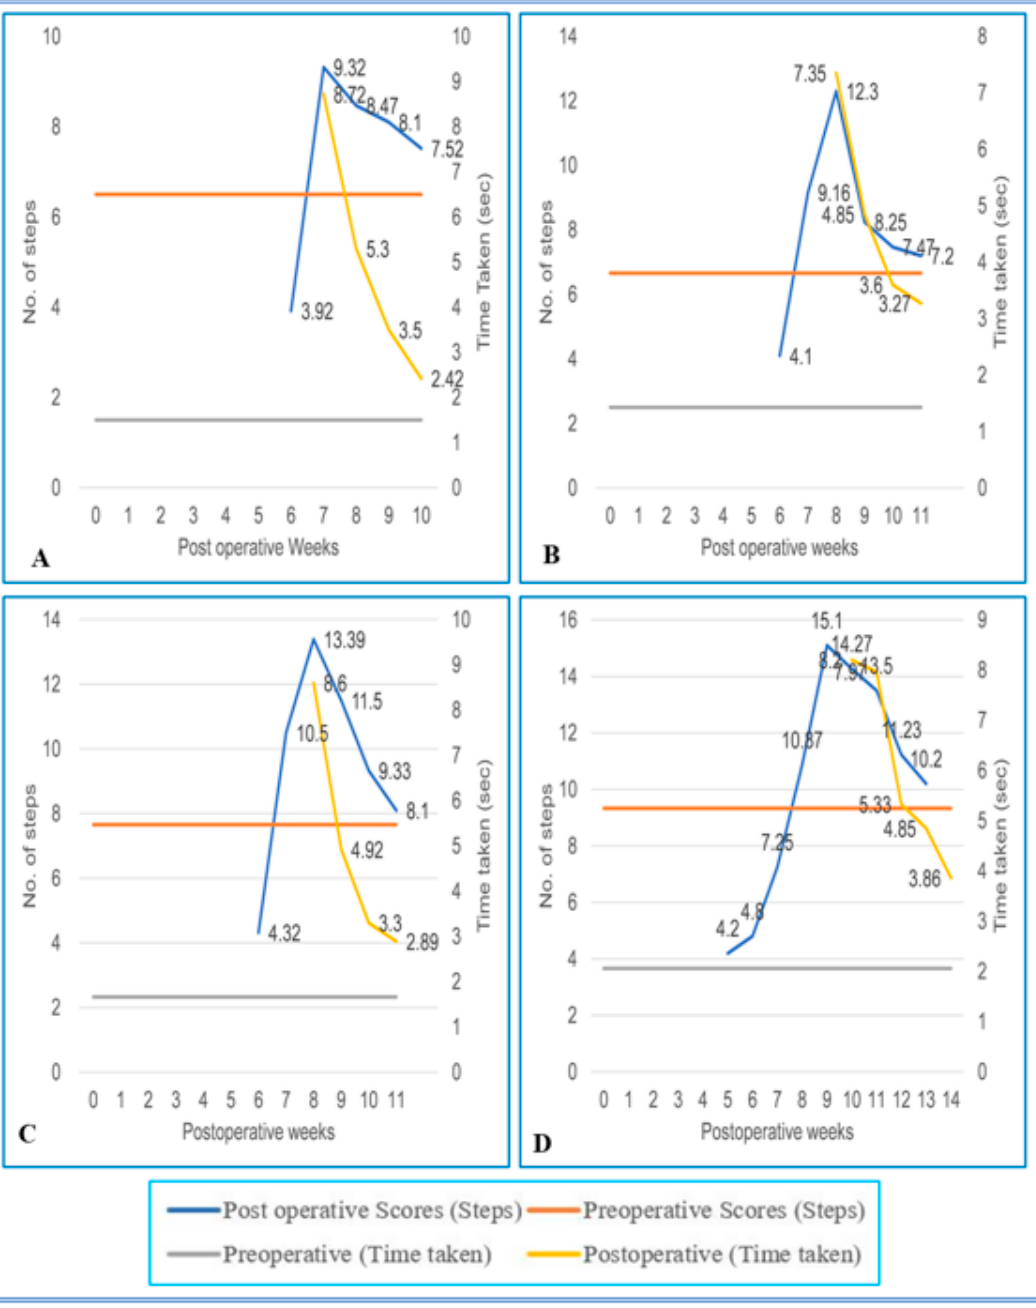
Figure 8. ( A – D ) Evaluation of locomotor behavior in grid runways after SPC hemisection as well as predegenerated peripheral nerve transplantation in Bonnet monkey ( Macaca radiata ) on Grid runways of 4, 5, 6, and 7 cm intervals respectively. Primary X-axis represents duration of recovery of locomotor functions in terms of weeks; primary Y-axis and secondary Y-axis represent the number of steps and time taken by the spinal cord unilateral hemisection as well as predegenerated peripheral nerve transplantation monkeys to cross the grid runways.